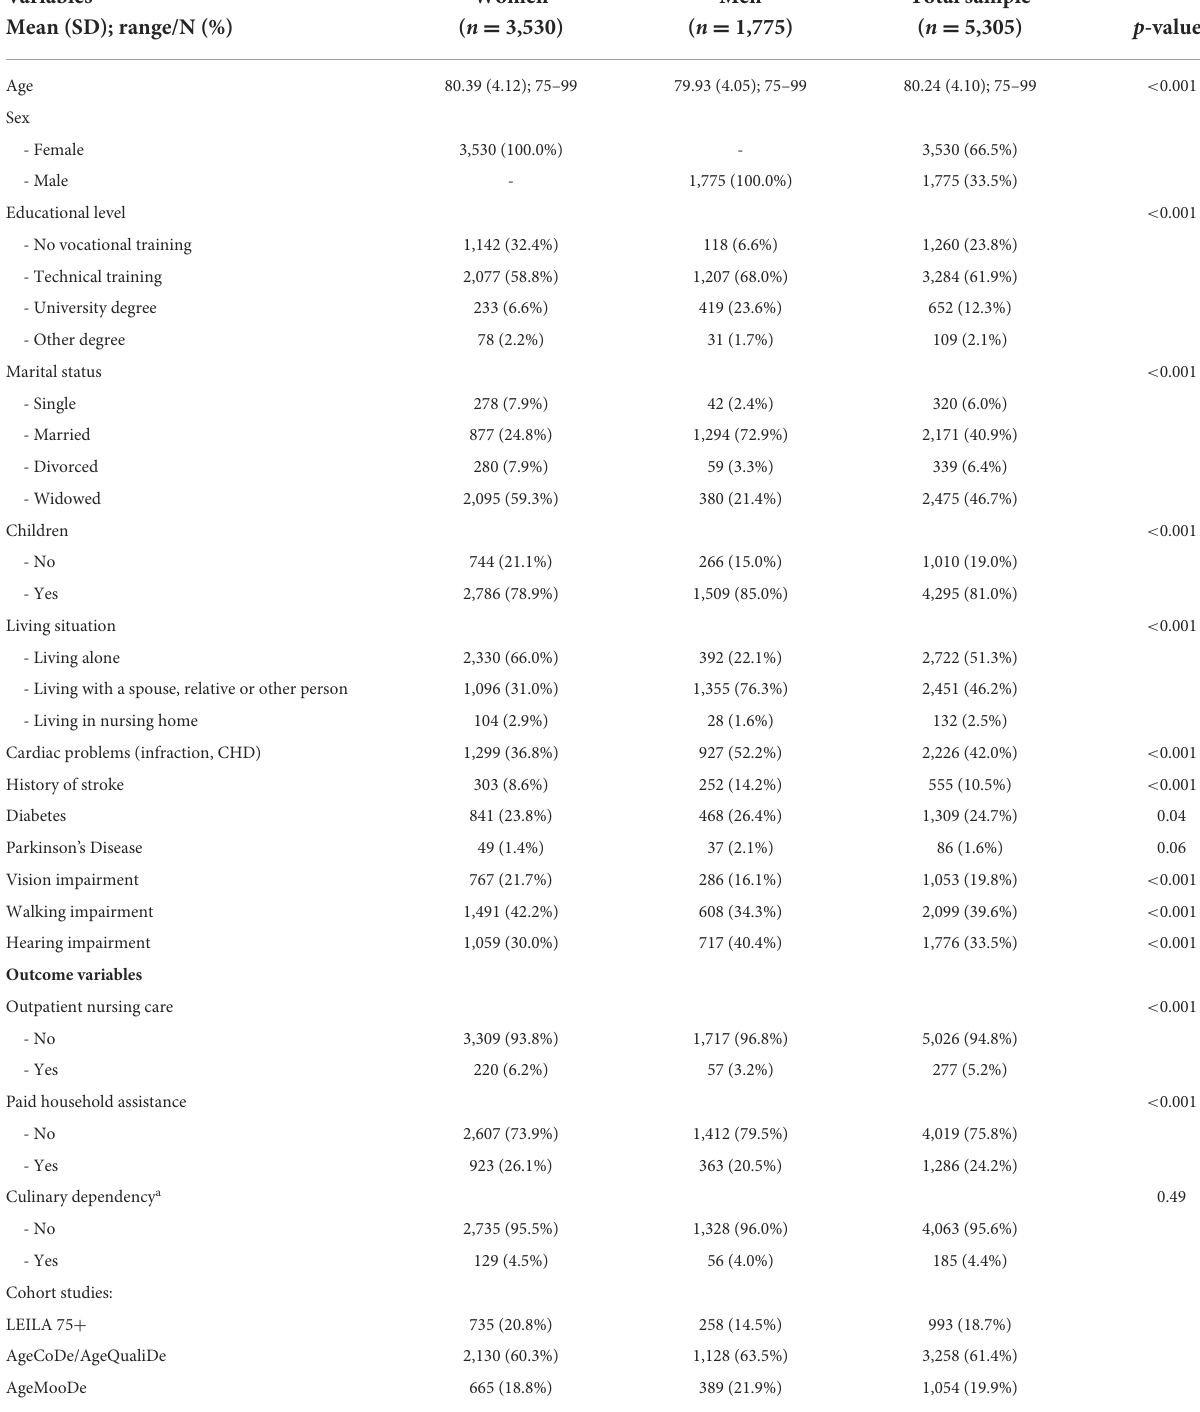
TABLE 1 Descriptive statistics of the analytical sample at baseline for the pooled data AgeDifferent.de platform. Variables